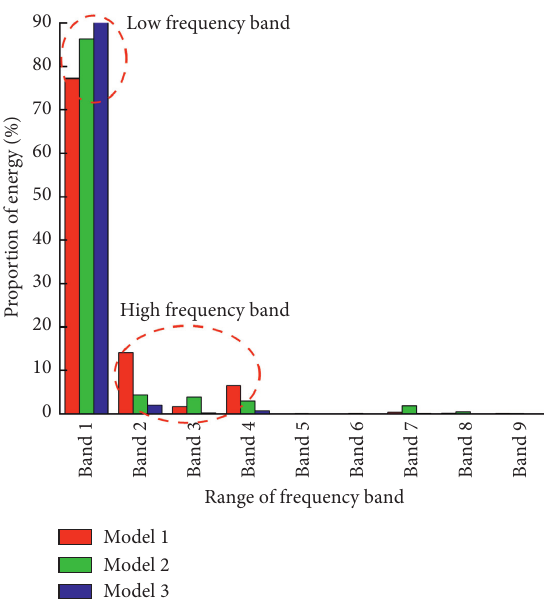
Figure 18: Comparison of the proportion of the frequency band energy of each model.